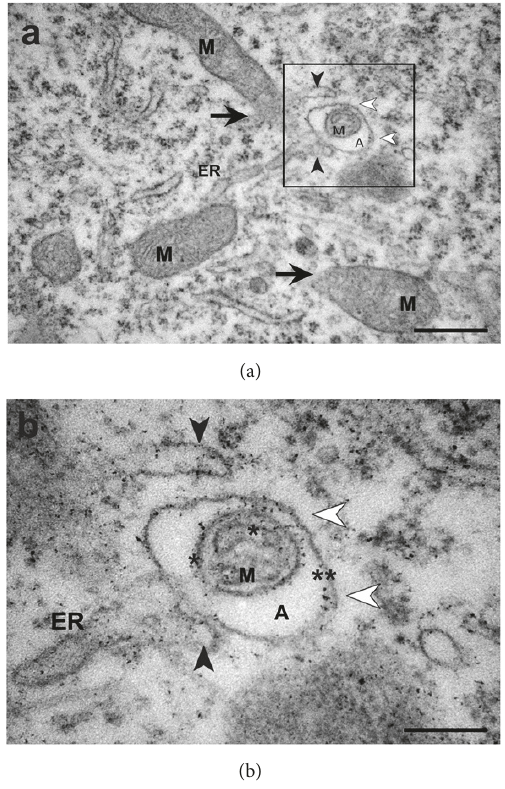
Figure 4: Effect of MeHg on vacuole formation in spinal cord cells of E10 embryos . Electron micrograph of the mantle layer showing the mitophagic profile in the black box (a). The insert in (b) shows a detail of mitochondria (M) surrounded by the autophagic vacuole membrane (white arrowhead). In detail (b) internal mitochondrial membranes(asterisk)andexternalmitochondrialmembranes(dou- ble asterisk) are visible. Endoplasmic reticulum (ER) can be seen close to the autophagic vacuole (A) maintaining contact with it by membraneextensions (blackarrowhead). Scale bars: (a) 500 𝜇 m; (b) 200 𝜂